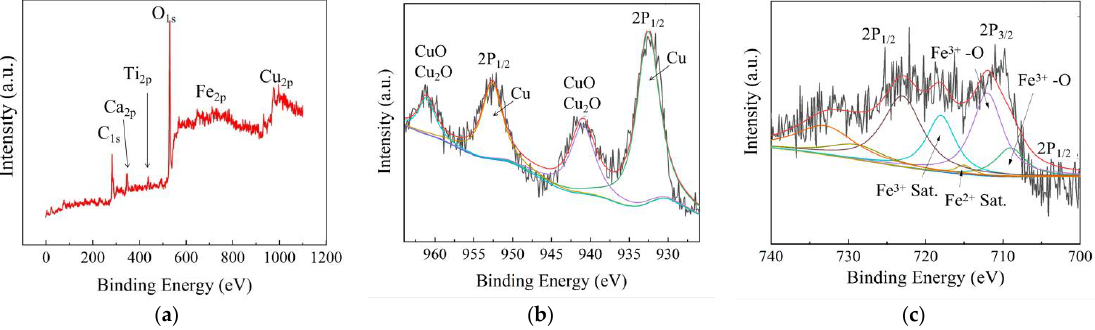
Figure 8. XPS analysis results on the LCG grease: ( a ) survey spectrum and the high-resolution spectra of ( b ) Cu 2p and ( c ) Fe 2p.